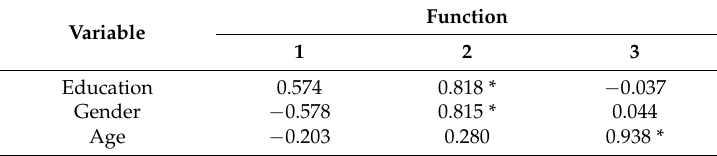
Table 4. Structure matrix for functions 1 through